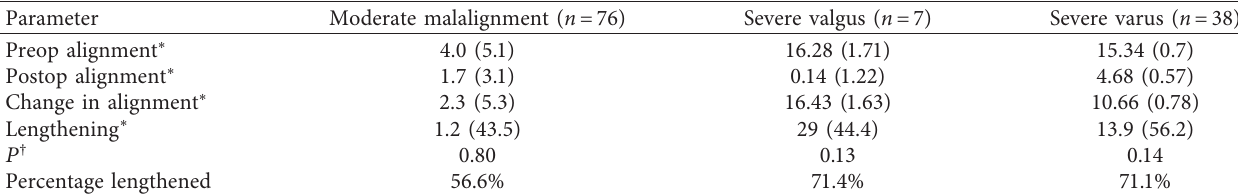
Table 3: Measurement results stratified by degree of